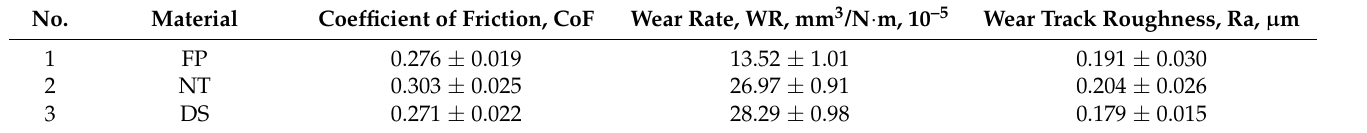
Table 4. The tribological properties of the PMMA dental materials in the point tribological contact.